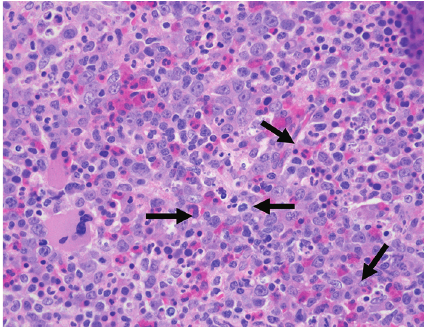
Figure 1: Bone marrow biopsy, H & E stain, hypercellular marrow, and increased histiocytes, which show hemophagocytosis (arrows).